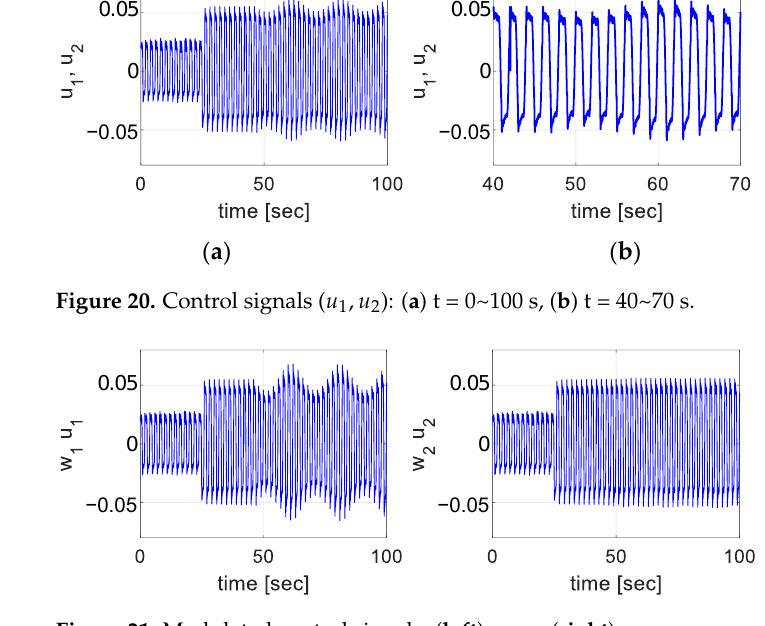
1 u 1 , ( right ) w 2 u 2